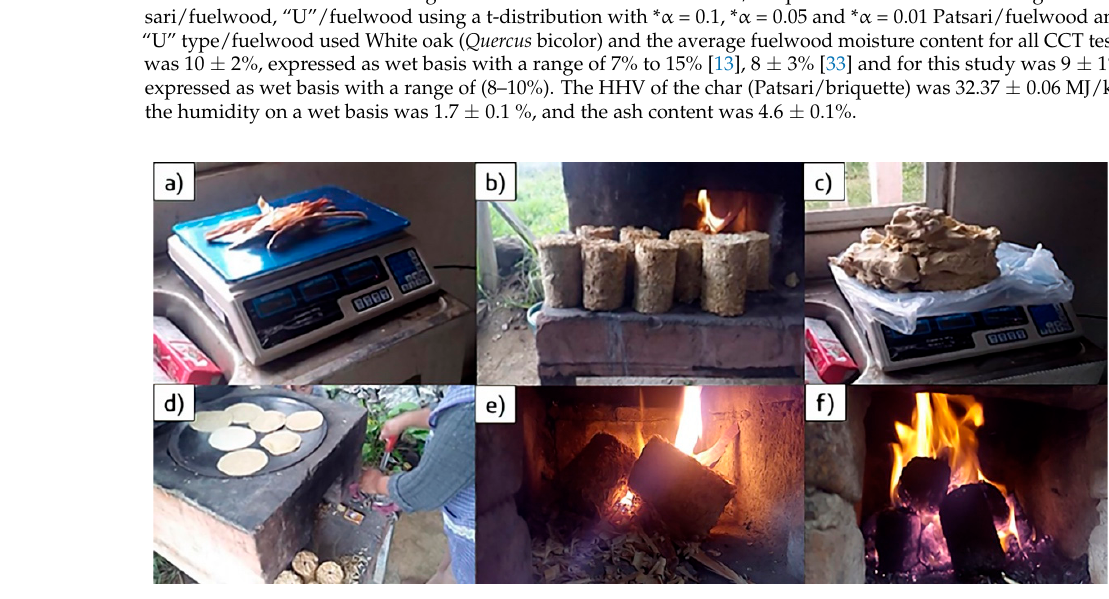
Figure 4. ( a ) Firestarter (weight), ( b ) Briquettes (biofuel), ( c ) Tortilla dough (weight), ( d ) Field cooking in the Patsari cookstove, ( e ) Combustion during the starting of the cooking test, ( f ) Generation of charcoal before finishing the test.